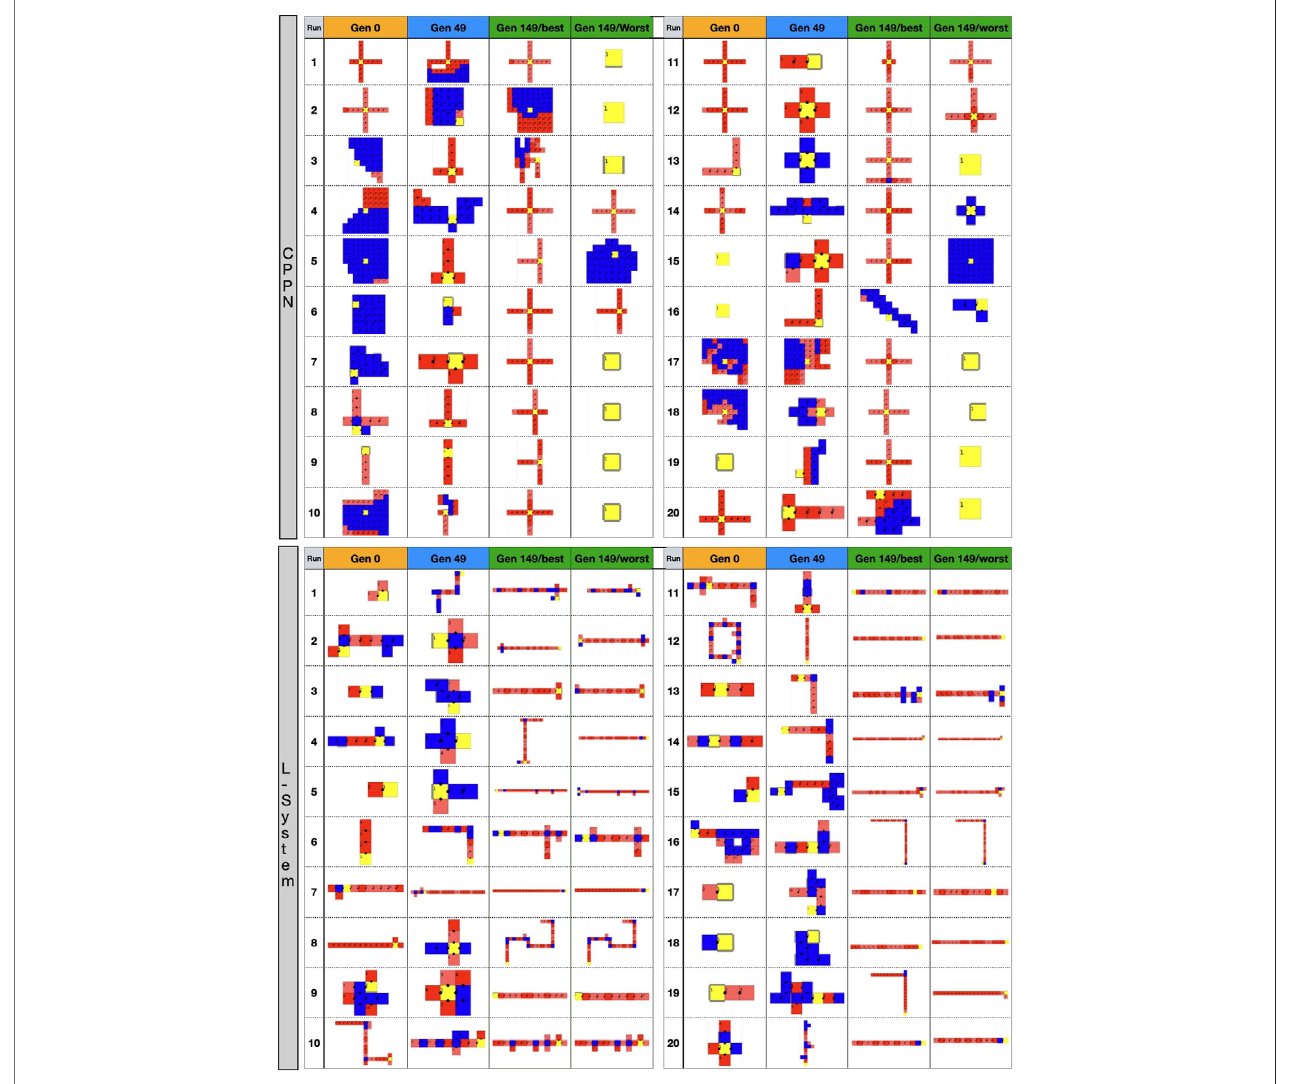
FIGURE6| Top-down2Dillustrationofrobotsindifferentstagesoftheevolutionaryprocess.Gen0:randomrobotfromprimaryinitialization.Gen49:randomrobot from secondary initialization. Gen 149/best: best robot after optimization. Gen 149/worst: worst robot after optimization. Images size was adjusted to fi t the cells.